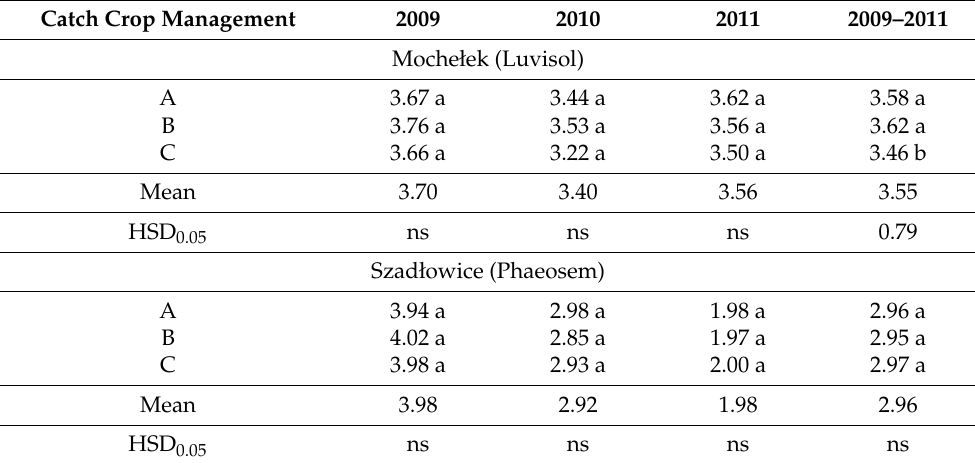
Table 8. Content of phosphorus (P) in spring barley grain (g kg − 1 ) depending on a catch crop management.